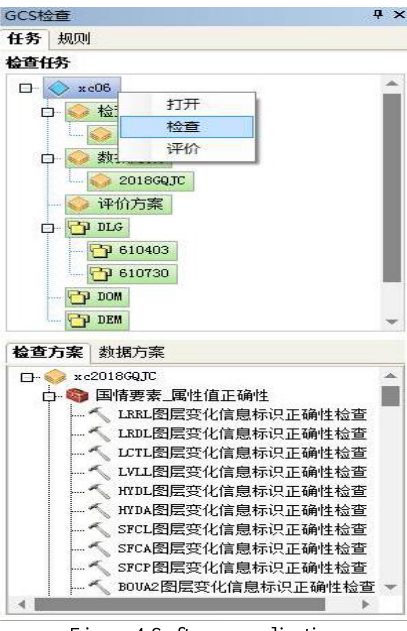
Figure 4.Software